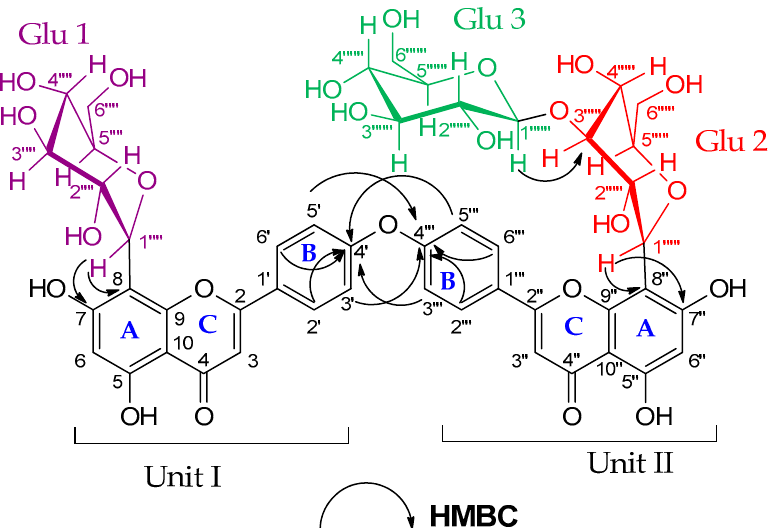
Figure 4. HMBC correlations of compound ( 7 ). (4 ′ ,4 ′′′ biapigenin-8 ″ -C- β -D-glucopyranosyl [1 ′′′′′′ → 3 ′′′′′ ] β -D-glucopyranoside-8-C- β -D-glucopyranoside).